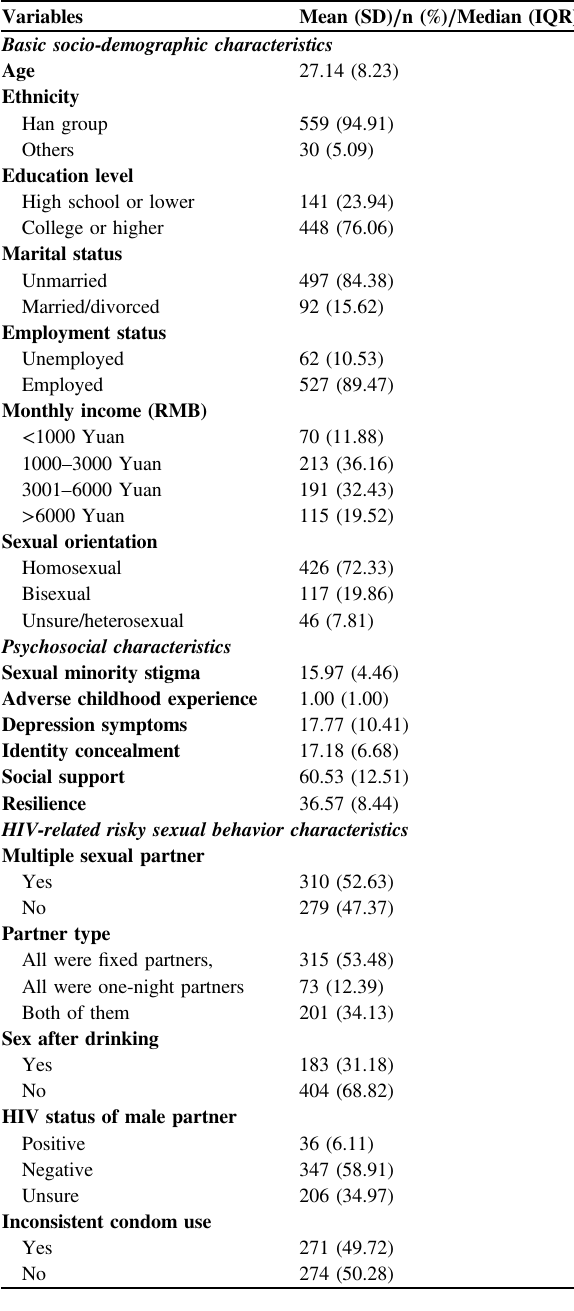
Table 1 Basic socio-demographic, psychosocial and HIV-related risky sexual behavior characteristics of samples (N = 589).